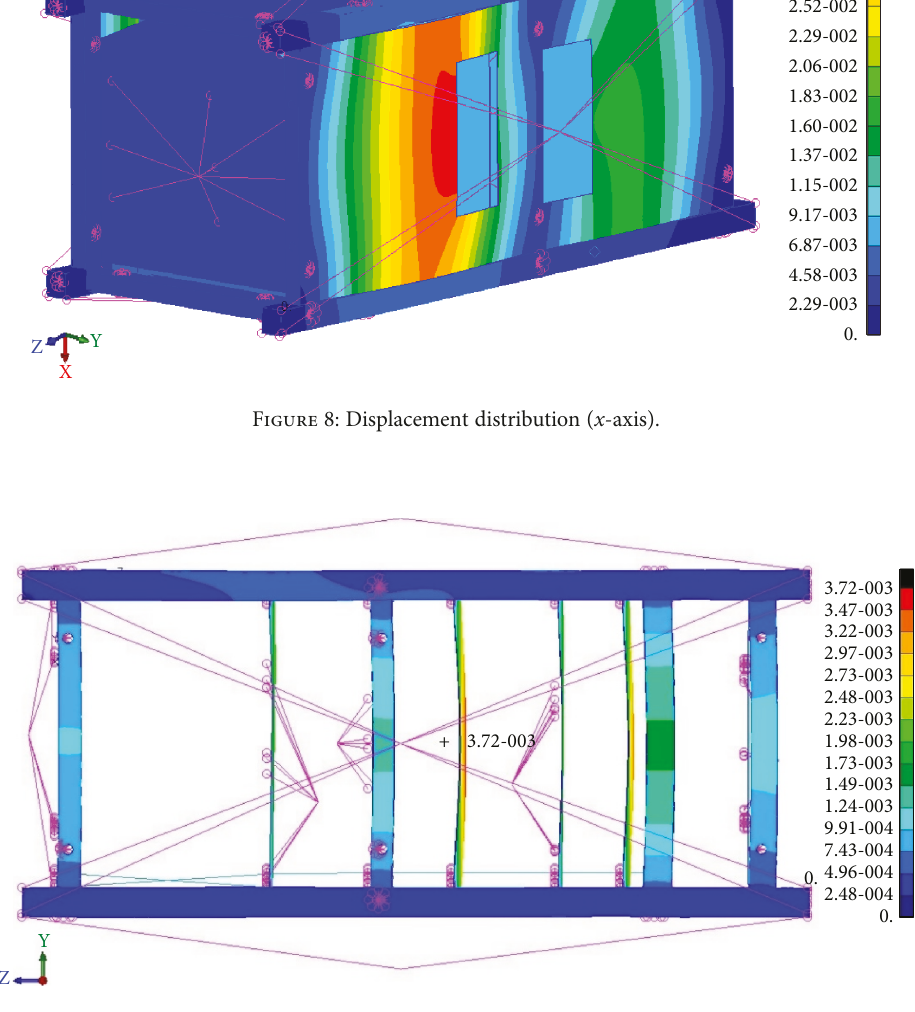
Figure 9: Stress distribution ( z